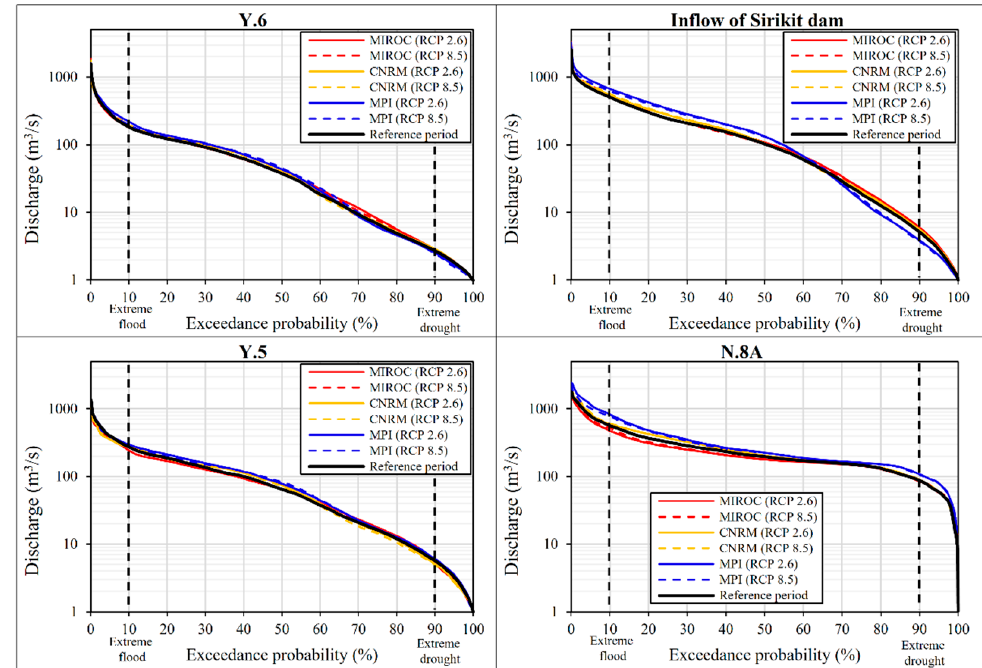
Figure 9. Flow Duration Curve during the near future (2021–2045) under scenarios RCP 2.6 and RCP 8.5 compared with the reference period.